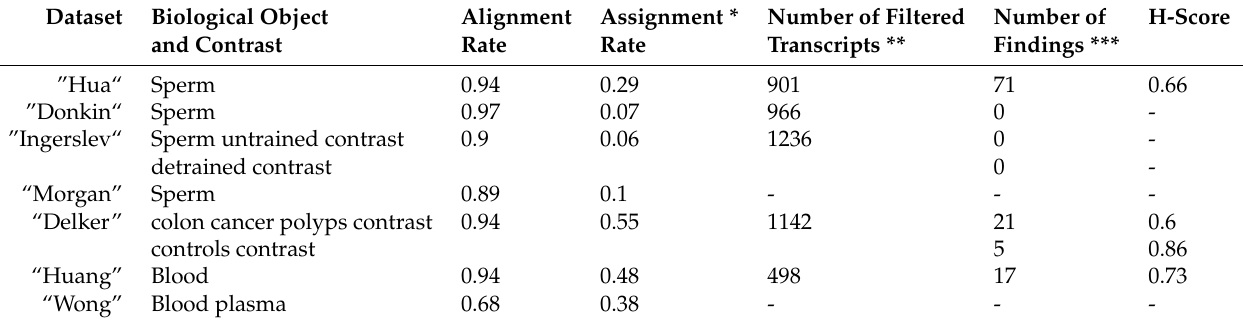
Table 3. Results for bowtie -v 1 pipeline; *—assigned/aligned; **—mean (counts) > 5; ***—DESeq2